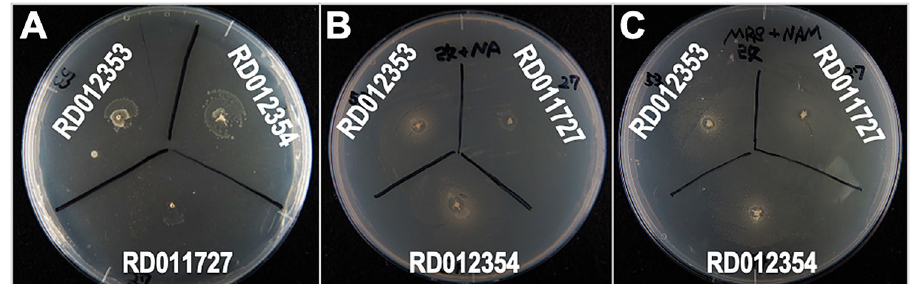
Figure 5. Effect of NA and NAM on the extracellular production of NMN/NR. Each candidate LAB was spotted onto a MRSS plate spread with NR-auxotrophic yeast as described in Fig. 1, and cultivated at 30 °C for